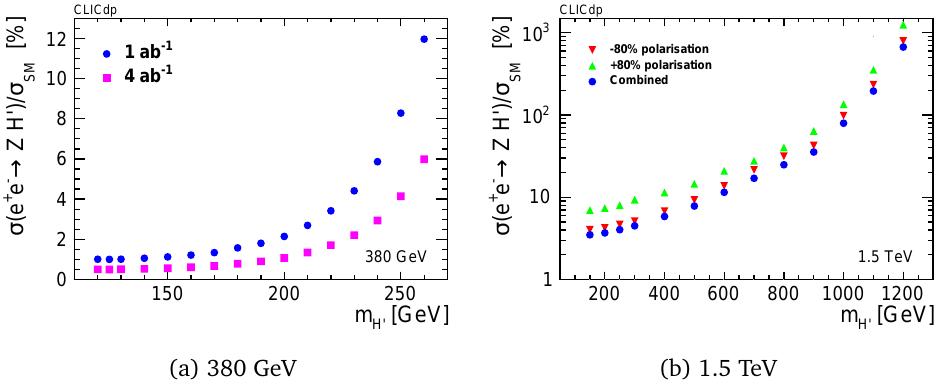
(cid:48) production,